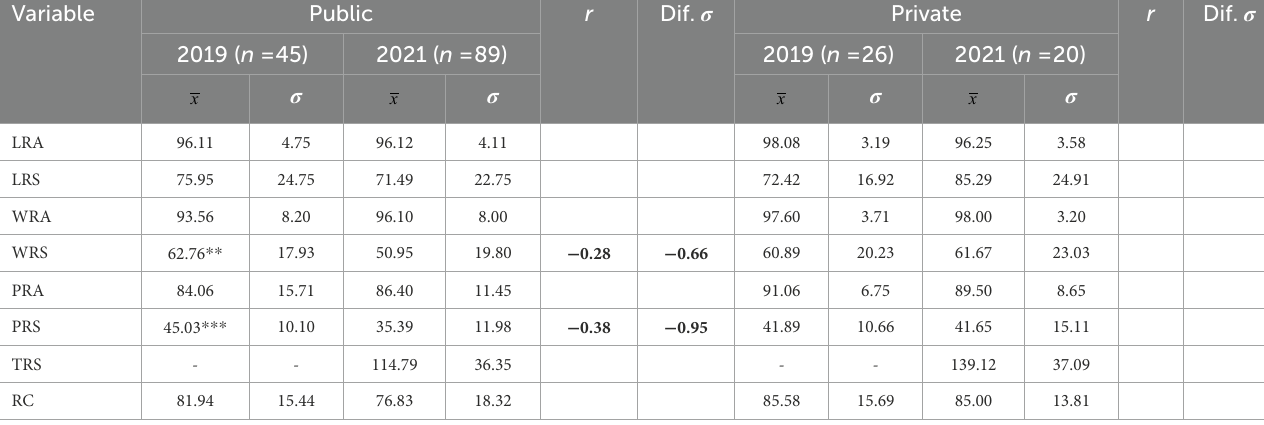
TABLE 6 Averages and pre-post pandemic differences in sixth grade (public vs. private). Variable